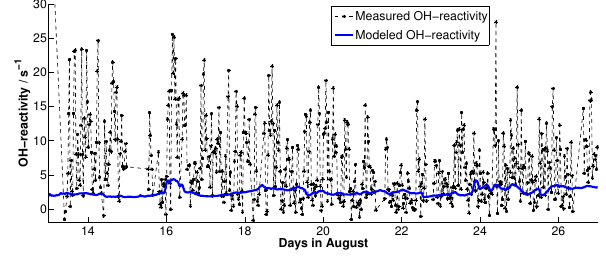
Fig. 1. Modelled (blue) and 30min resolution measured OH- reactivity (black) from the 13 to 27 August 2008.